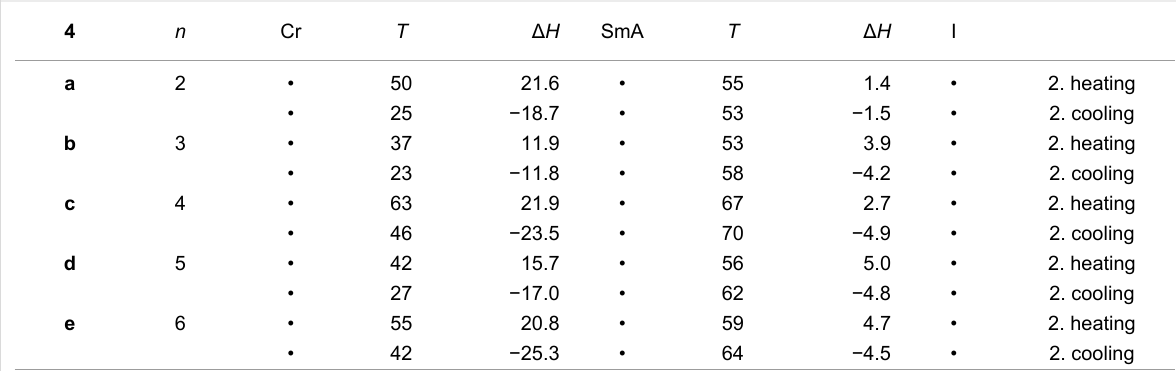
Table 2: Phase transition temperatures [°C] and enthalpies [kJ/mol] of compounds 4 . a 4